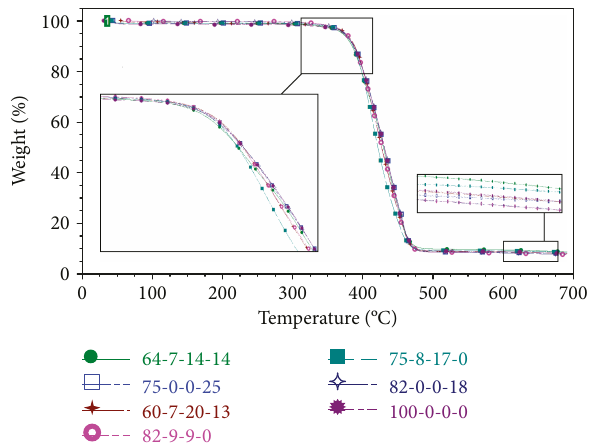
Figure 5: TGA curves of the composites prepared via the new